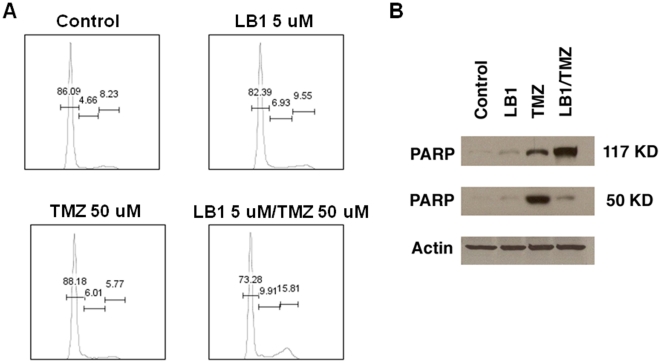
Effect of LB1 and TMZ on tumor cell cycle and apoptosis.(A) Cell cycle analysis of MPC cells in exponential growth exposed for 48 hours to vehicle alone; LB1 alone at 5 µM; TMZ at 50 µM and; LB1 at 5 µM and TMZ at 50 µM. (B) PARP expression changes in 24 hours after treatment of mice bearing hepatic tumors with vehicle, LB1 alone at 1.5 mg/kg by gavage, TMZ alone by gavage at 80 mg/kg, of both drugs at the same doses.